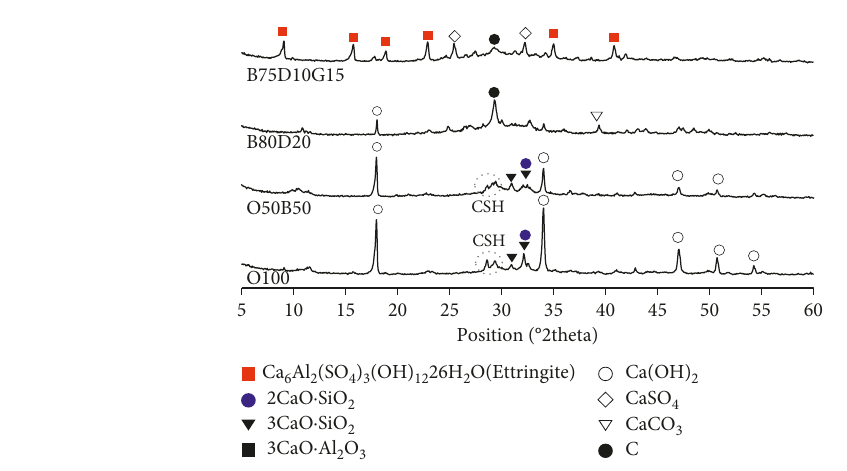
Figure 6: XRD spectra.